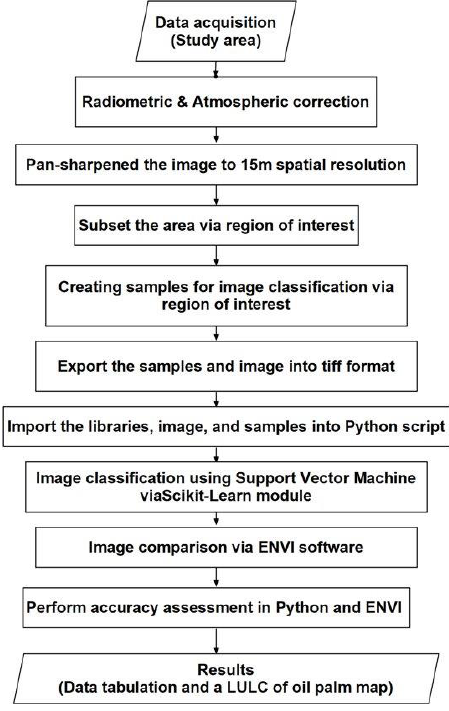
Figure 2. Flow chart for the work